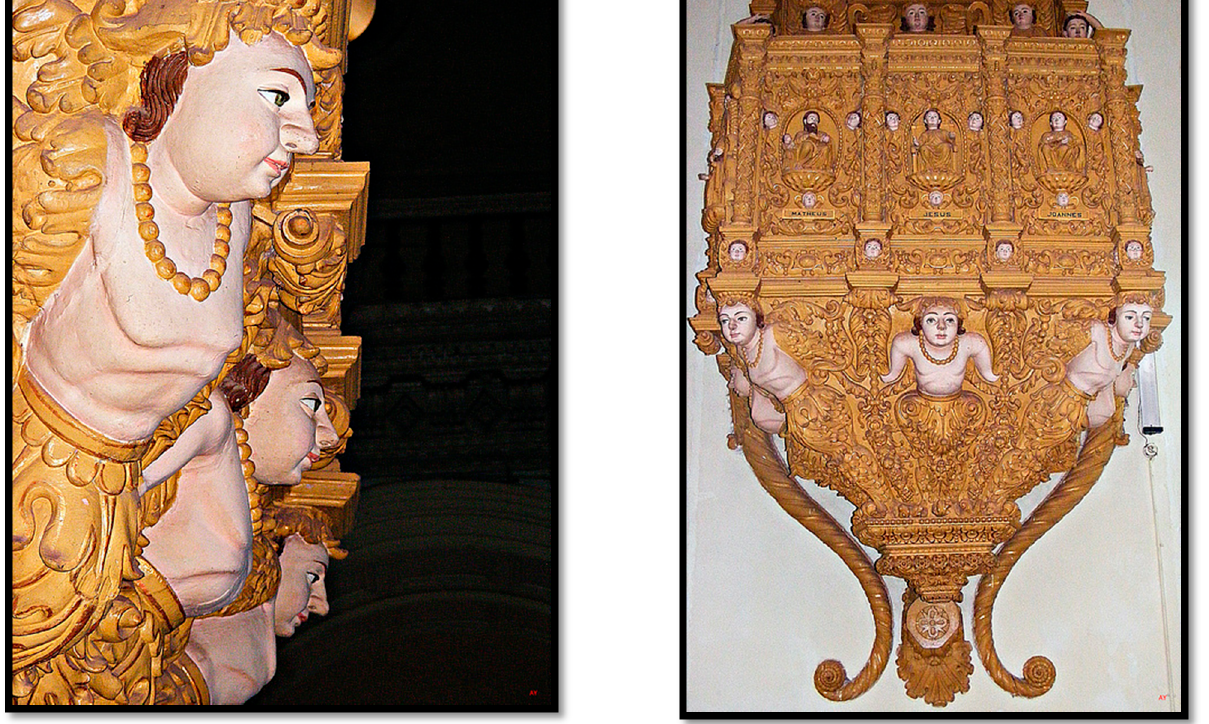
Figure 9. Polychrome wooden pulpit, Basilica of Bom Jesus, 17th century, Goa.